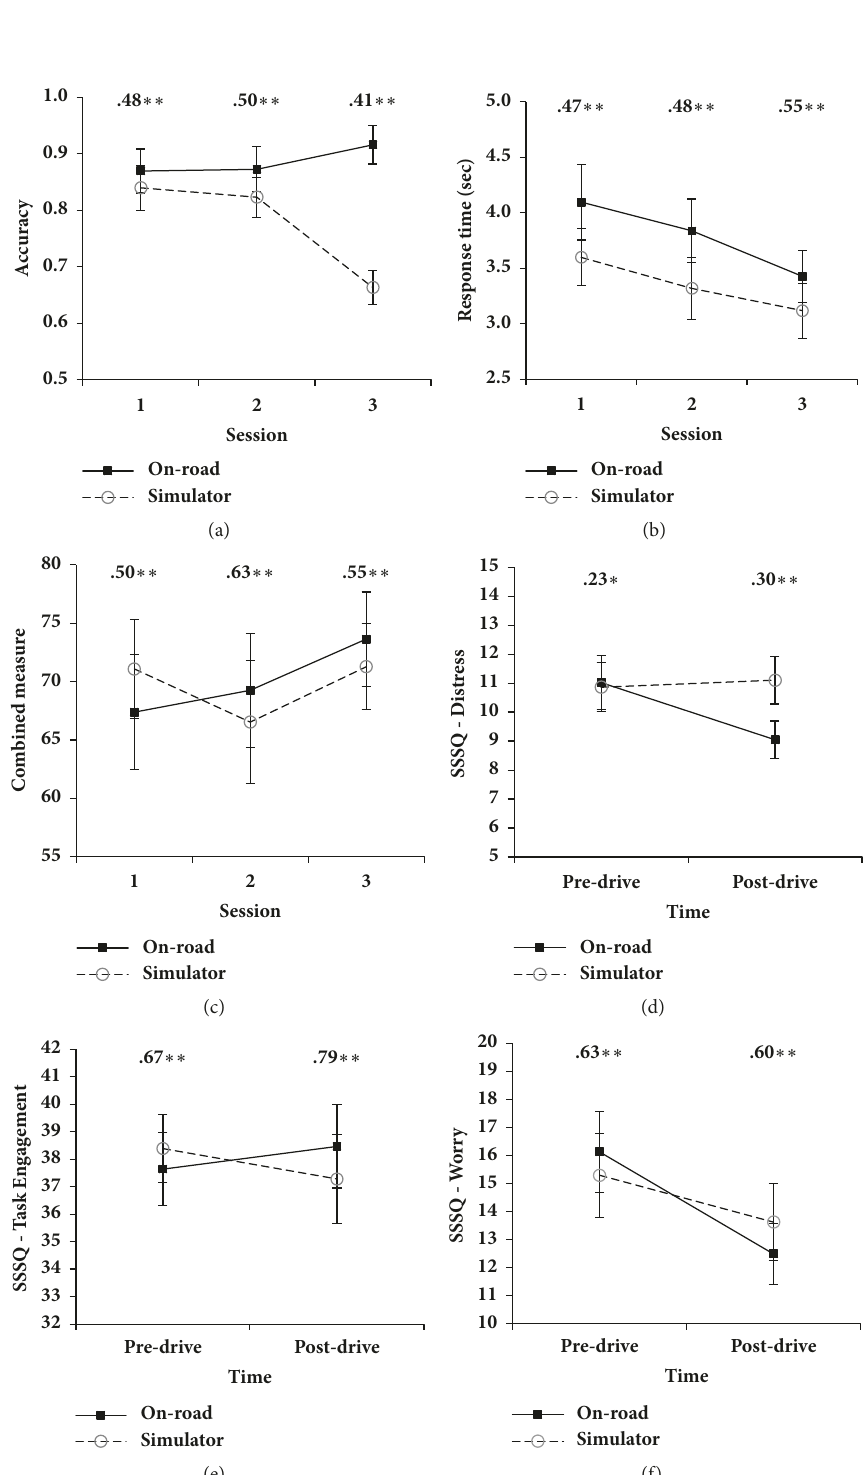
Figure 2: On-road vs. simulator mean score comparisons of behavioral measures of the workload (rotated figures task scores: (a) accuracy; (b) response time; (c) combined time/correctness measure) across the three dual-task sessions and of stress measures before and after drive (Short Stress State Questionnaire [SSSQ] scores: (d) Distress, (e) Task Engagement; (f) Worry). Figures inside the graph are Pearson's zero- order correlations between the scores in the simulator and scores on the road as an index of relative validity (n = 87); ∗ : p < 0.05 and ∗∗ p <